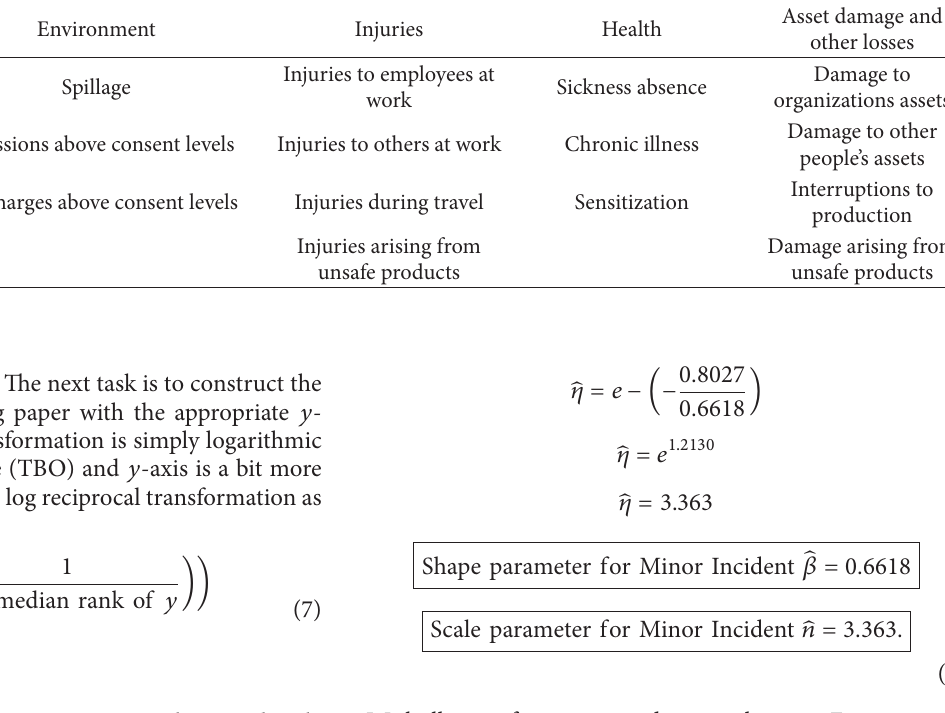
Table 1: The main types of accident and incident